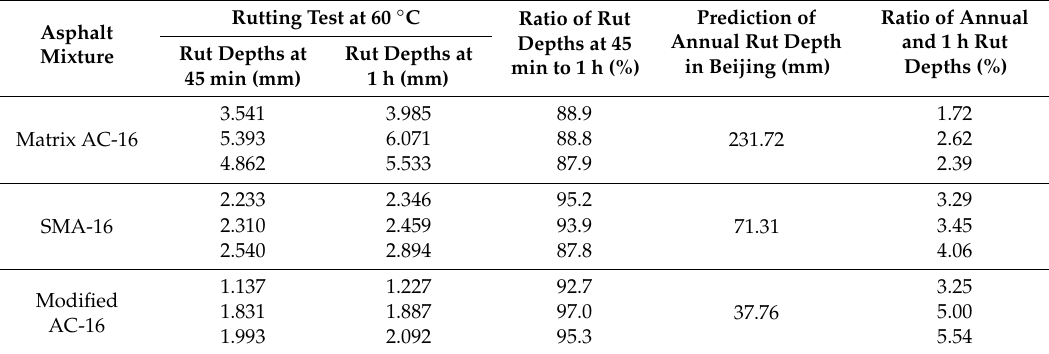
Table 5. Rut depths at 45 min and 1 h of rutting test and total annual predicted rut